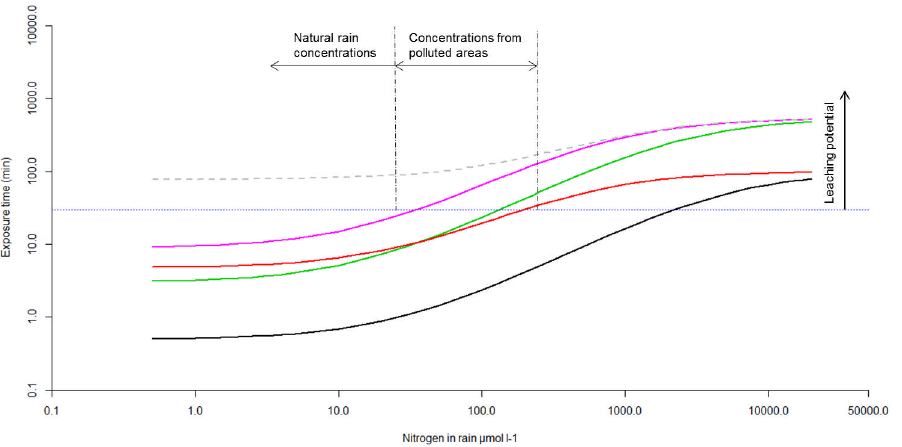
Figure 6. Exposure time of mosses to nitrogen increases non-linearly at increasing nitrogen concentrations. We used a conceptualized relationship (log-log) between nitrogen concentration in rain and exposure time for a living Sphagnum layer that would need to retain some 90% of the nitrogen load. The area below the horizontal dots (average residence time of rain) indicates an increasing potential of nitrogen leaching through the living layer of mosses. Maximum uptake rates V max differ between scenarios: black ‘‘ammonium pulse’’ 28 m mol N gDW 2 1 h 2 1 , green ‘‘ammonium long’’ 2.8 m mol N gDW 2 1 h 2 1 , red ‘‘nitrate pulse’’ 2.5 m mol N gDW 2 1 h 2 1 , purple ‘‘nitrate long’’ 0.8 m mol N gDW 2 1 h 2 1 and grey dashed line ‘‘nitrate low affinity’’ 0.8 m mol N gDW 2 1 h 2 1 , respectively. The model was parameterised with a K m of 6.5 m M for ammonium and a K m of 3.5 m M for nitrate. The ‘‘nitrate low affinity’’ was calculated with a K m of 35 m M. An increasing potential of leaching is expected above the dotted black line that indicates the upper limit of residence time of rain. Average nitrogen concentrations in rain ( m mol N l 2 1 ) relate to yearly wet deposition of nitrogen (kg ha 2 1 ) by a factor 0.1 (yearly rainfall 750 mm).